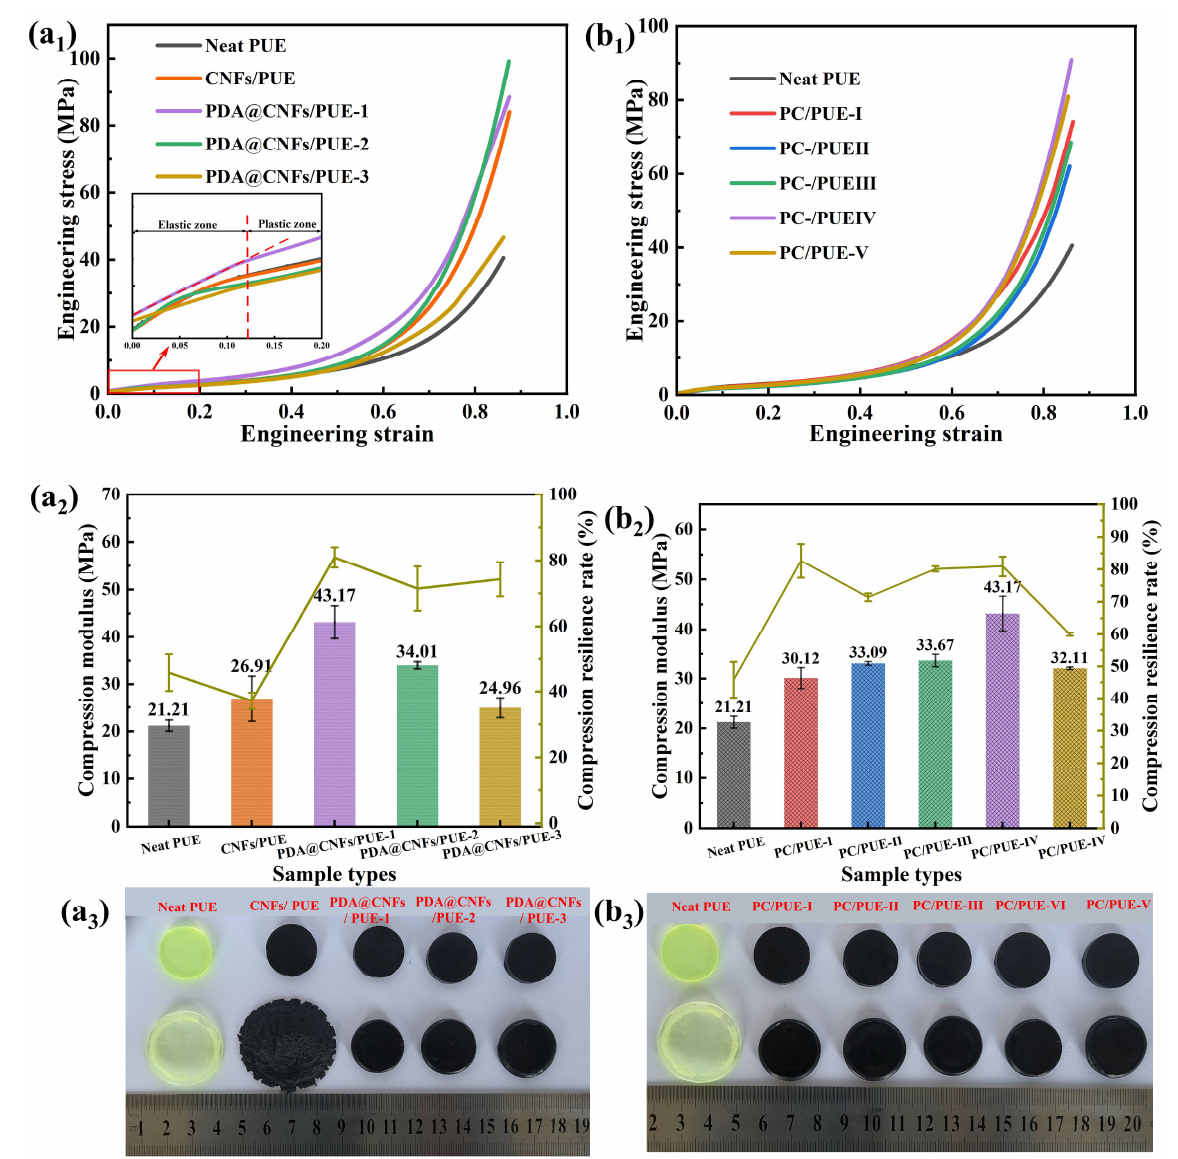
Figure 5. ( a 1 ) Stress–strain curves of difference concentration of DA to modify CNFs in PUE matrix. ( a 2 ) Compression modulus and compression resilience rate of difference concentration of DA to modify CNFs in PUE matrix. ( a 3 ) Experimental graphs of PUE composites after static compression tests of difference concentration of DA to modify CNFs in PUE matrix. ( b 1 ) Stress–strain curves of different mass fraction at concentration of PDA@CNFs–1 in PUE matrix. ( b 2 ) Compression modulus and compression resilience rate of different mass fraction at concentration of PDA@CNFs–1 in PUE matrix. ( b 3 ) Experimental graphs of PUE composites after static compression tests of different mass fraction at concentration of PDA@CNFs–1 in PUE Table 3. Data summary of PUE composites under static compression experiment.